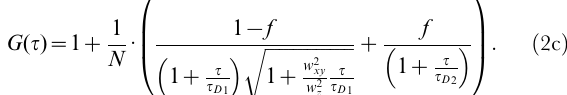
In equation (2c) N is the average number of ligand molecules in the observation volume element; the first term in the parenthesis